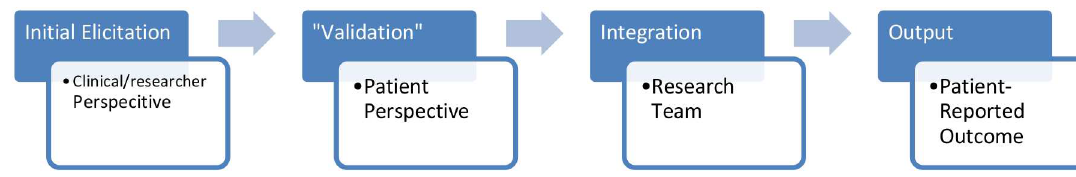
Fig 1. Typical paradigm for developing patient-reported outcomes.